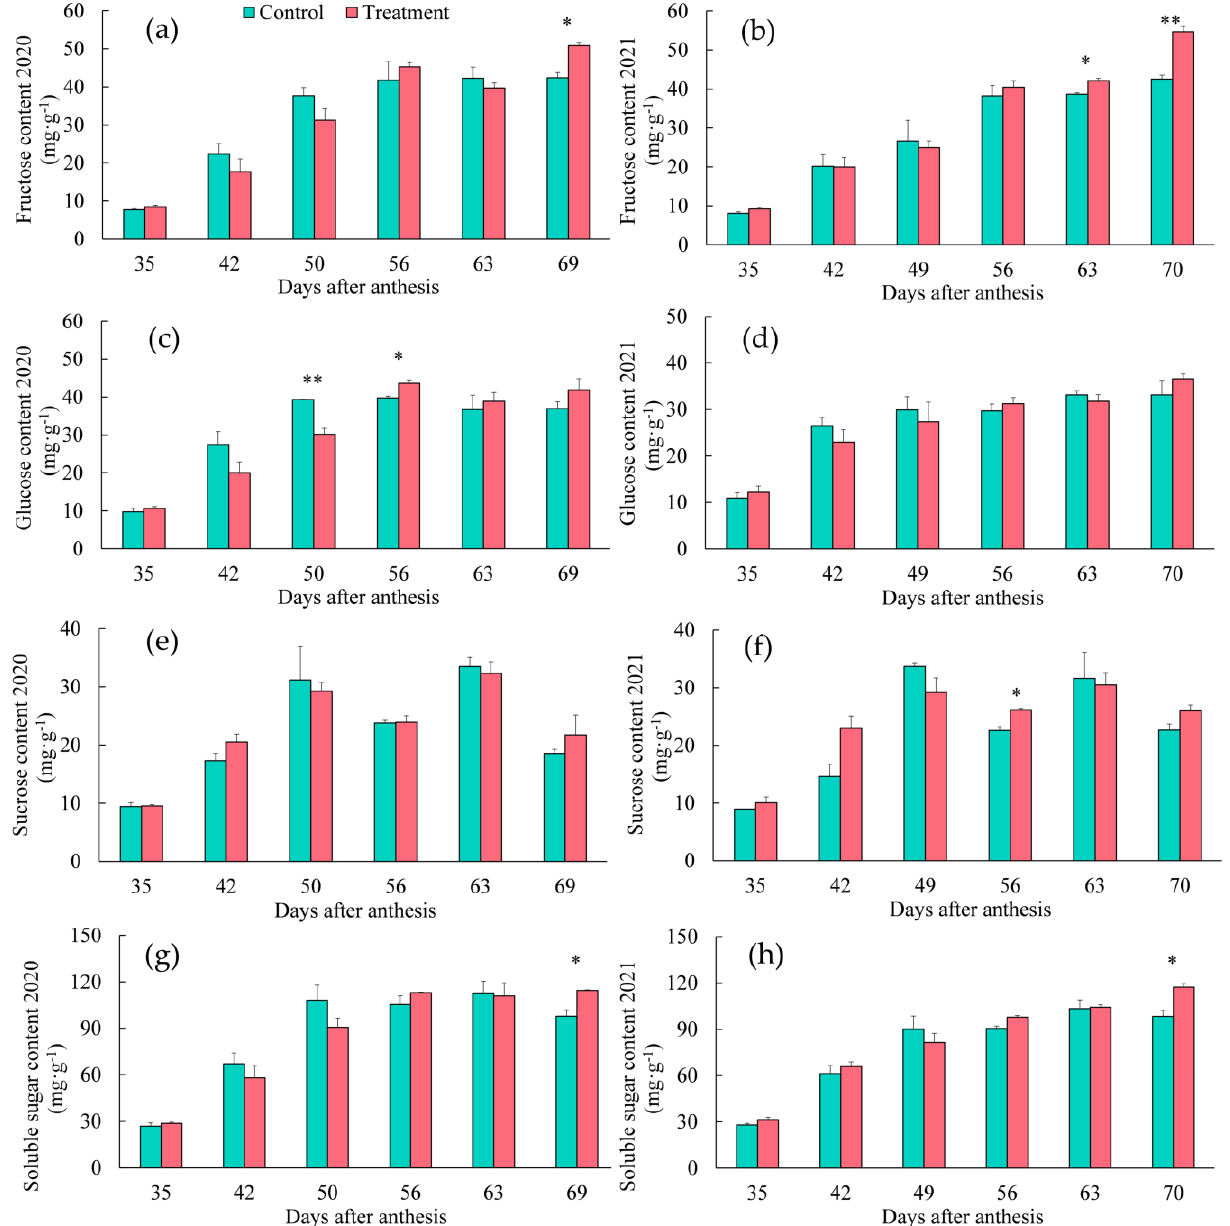
Figure 1. Dynamic changes in sugar contents in ‘Feizixiao’ litchi pulp between the treated and control group in 2020 and 2021: ( a , b ) fructose; ( c , d ) glucose; ( e , f ) sucrose; ( g , h ) soluble sugar. ** indicates a significant difference at the p < 0.01 level, * indicates a significant difference at the p < 0.05 level. Error bars are expressed as standard errors.